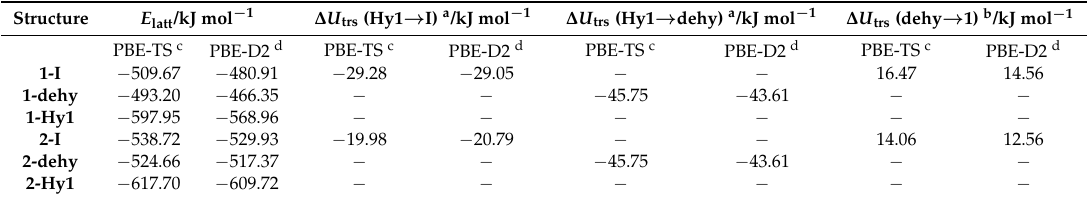
Table 2. Lattice energy calculations ( E latt ) and potential energy differences ( ∆ U ) between experimental and computed 1 and 2 crystal